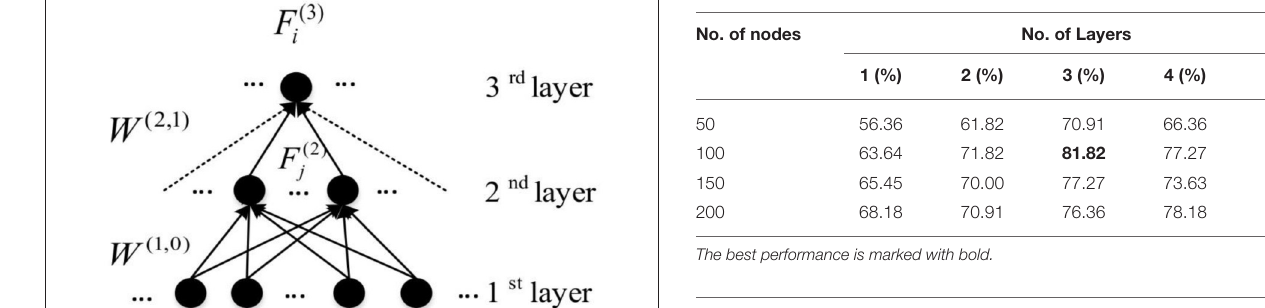
TABLE 3 | Results from the DNN-woFS in different scenarios.